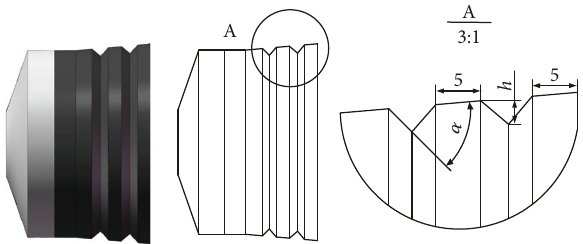
Figure 2: Striped piston and its structure and its dimensions (mm).